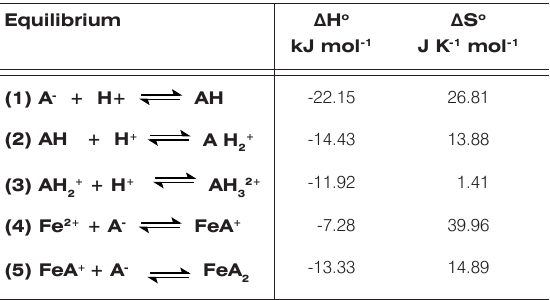
Table 4. Thermodynamic parameters for the equilibria of Fe 2+ complexes with 3,3-bis(1-methylimidazol-2-yl)propionate.